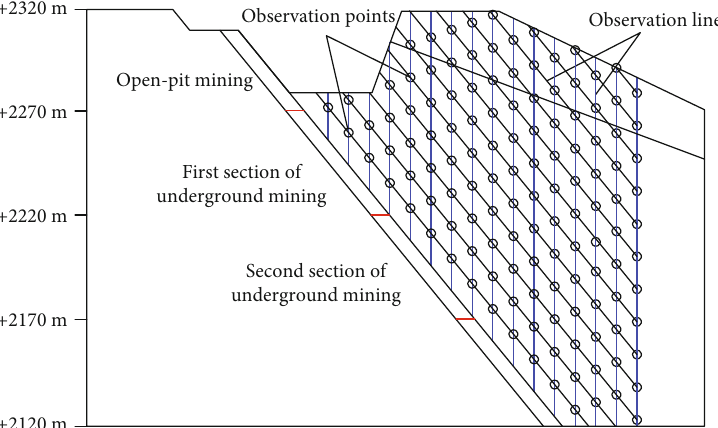
Figure 2: Simulation monitoring scheme.